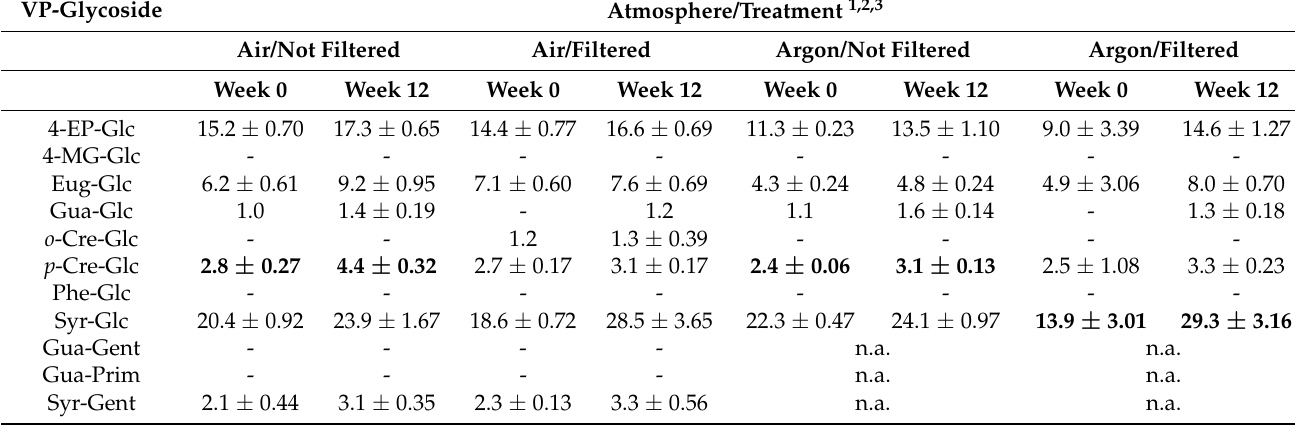
Table 1. Recovery of free VPs from model wine matrix (pH 3.6) fortified with VP-glycosides (200 ng/g) after 12 weeks of spontaneous